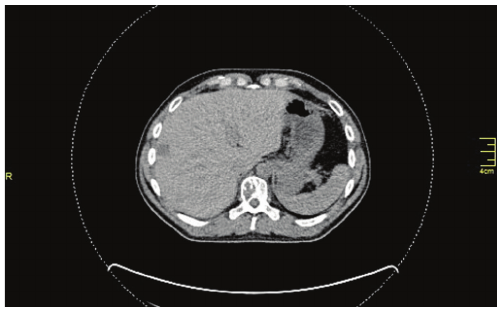
Figure 3: Liver metastasis, segment VIII.